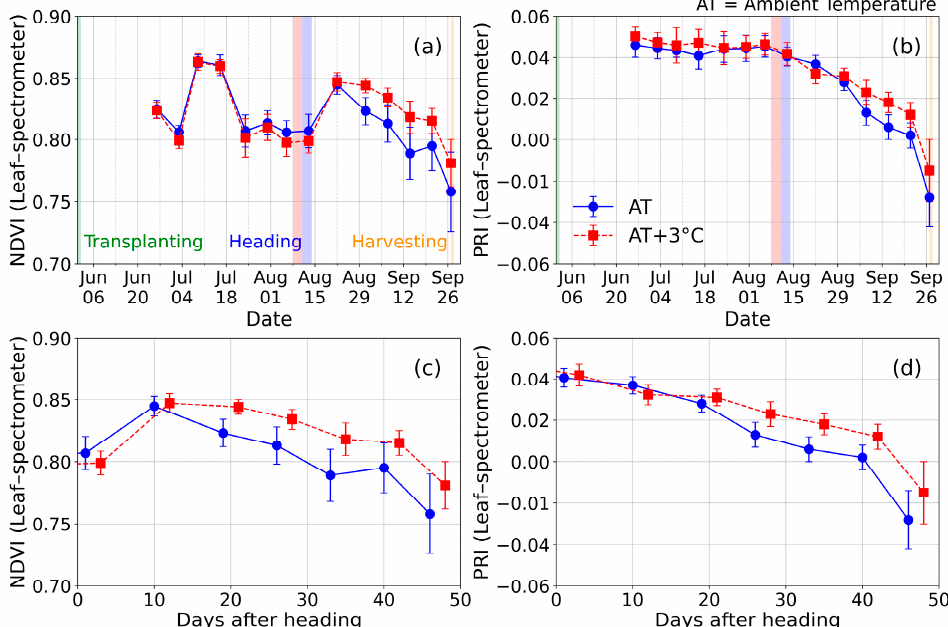
Figure 6. Time series of the NDVI and PRI measured from leaf-spectrometer (leaf scale) depending on heat stress. Time series of ( a ) NDVI and ( b ) PRI during cultivation periods. Changes in ( c ) NDVI and ( d ) PRI after the heading date.